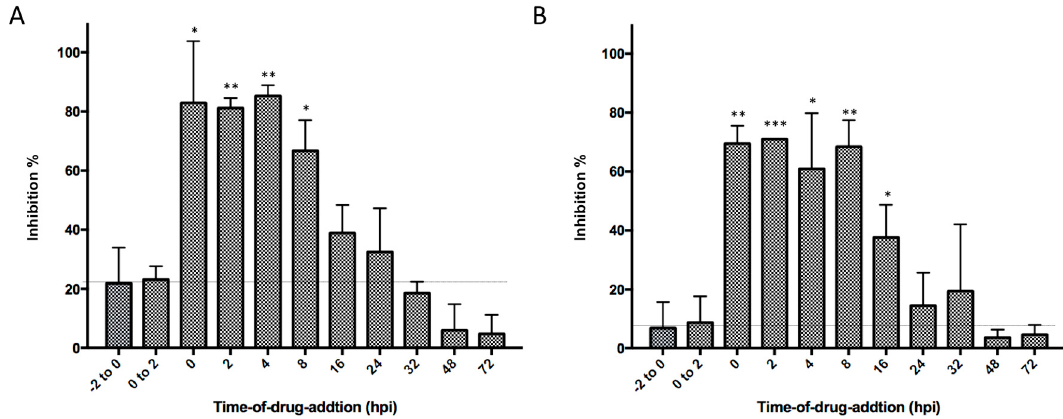
Figure 5. Time-of-drug-addition assay of Compounds 1 and 2 . ( A ) Inhibitory activities while treated with Compound 1 under a concentration of 20 µ M at various time points (from − 2 to 0 h post infection (hpi), from 0 to 2 hpi, at 0, 4, 8, 16, 24, 32, 48, and 72 hpi, respectively). ( B ) Inhibitory activities while treated with Compound 2 under a concentration of 50 µ M at the above time points.